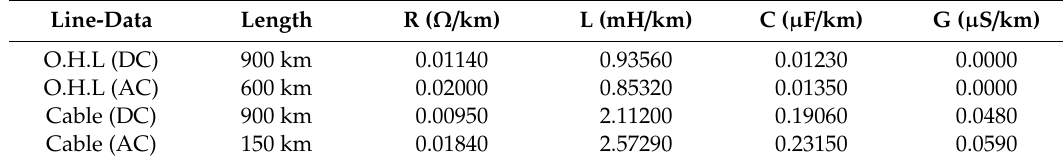
Table 4. CIGRE B4 transmission lines data.